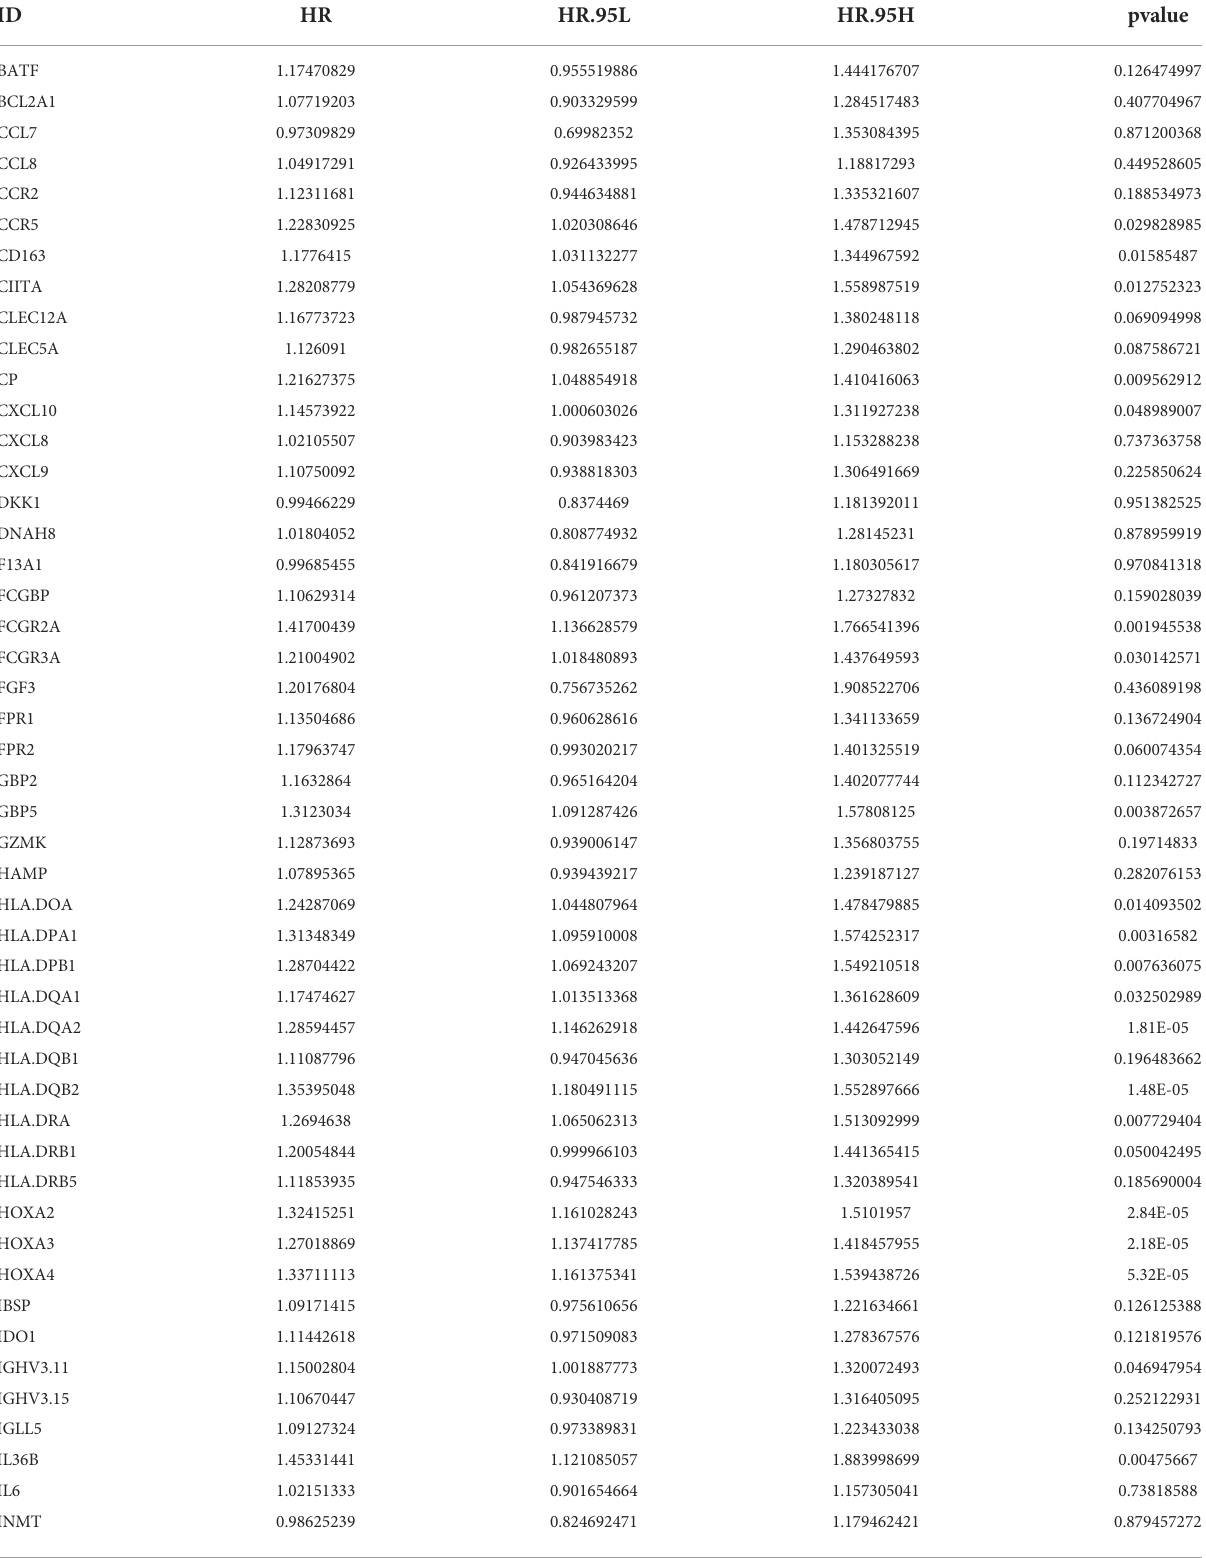
TABLE 1 The hazard rate of genes for glioma patients with